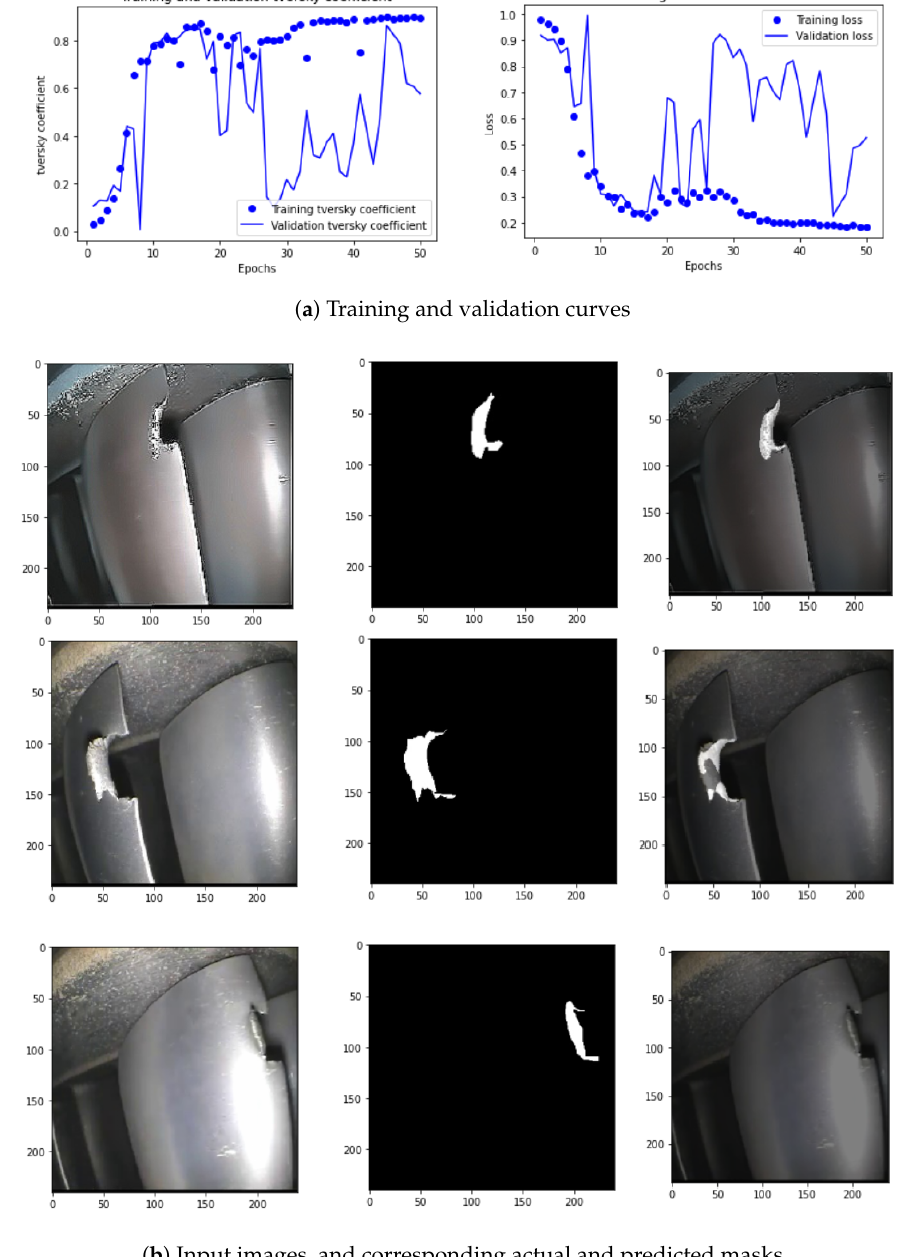
Figure 10. Results for the model with focal Tversky loss at 50 epochs.